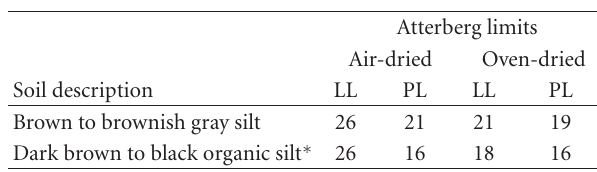
Table 1: Laboratory subgrade classification test